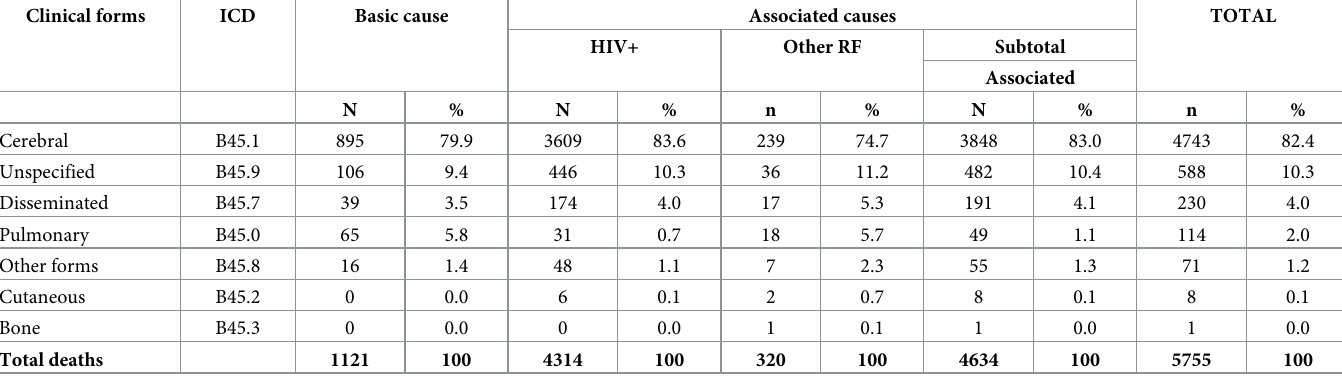
Table 3. Deaths of cryptococcosis, according to clinical form, by basic and associated causes. Brazil, 2000 to 2012. Clinical forms